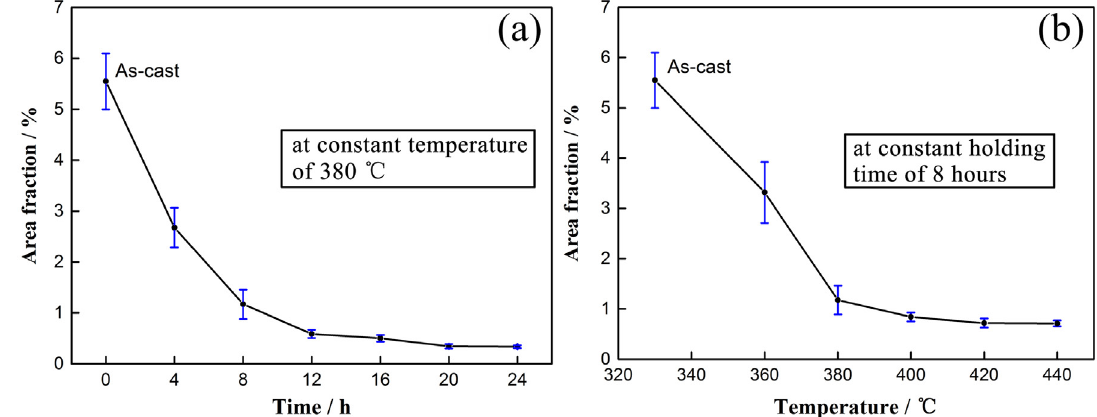
Figure 6. Evolution of average area fraction of secondary phases during homogenization (a) average area fraction versus holding time at a constant temperature of 380 ºC, (b) average area fraction versus temperature at a constant holding time of 8 h.